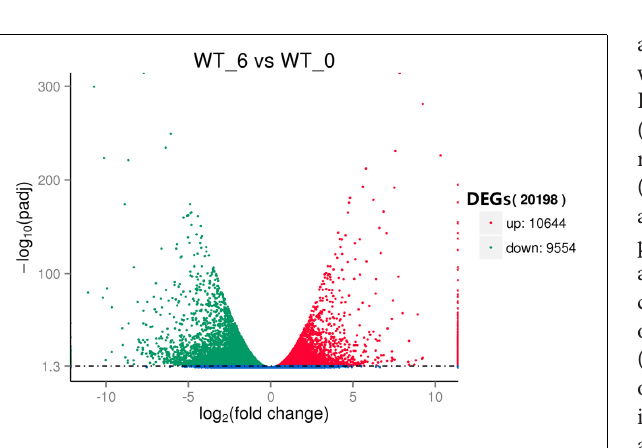
FIGURE 3 | Volcano plot of the differentially expressed genes (DEGs) between the control (WT_0) and heat stressed (WT_6) perennial